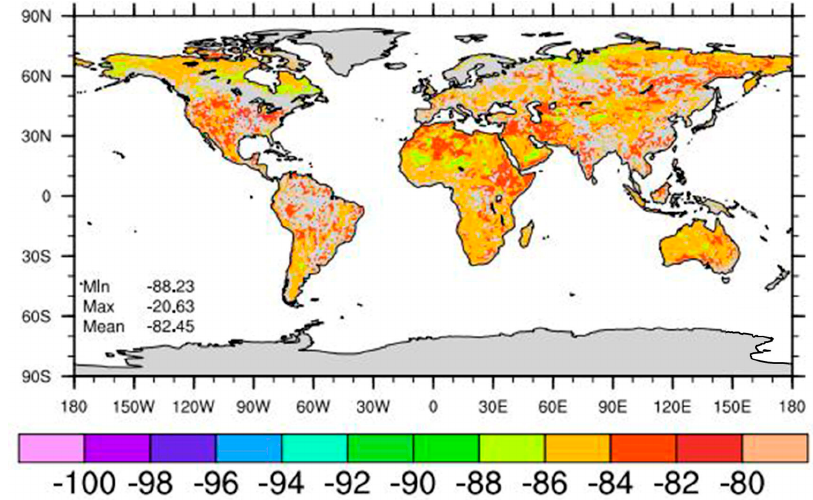
Figure 15. Relative differences (CoLM2014–CoLM2005)/CoLM2005 in dry soil thermal conductivity averaged across ten model soil layers (unit: %).